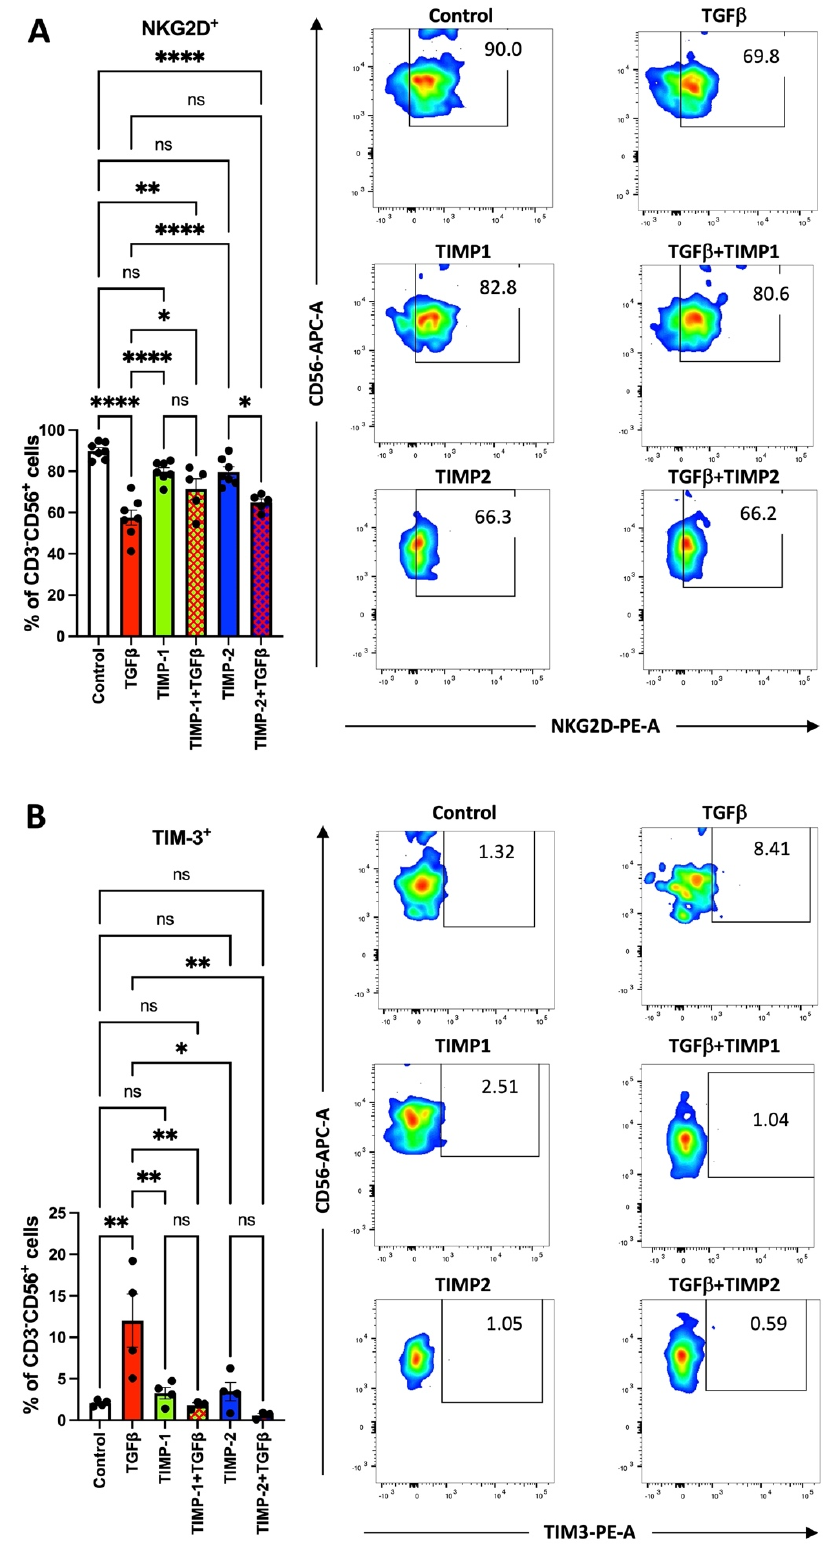
Figure 3. TIMP-1 and TIMP-2 treatments were effective in contrasting the TGF β -induced ability to decrease the surface expression of the NK cell activation marker NKG2D (panel A ) and the expression of the TIM-3 (panel B ) exhaustion marker. Results are shown as mean ± SEM, ANOVA, ns = not signficant; * p < 0.05; ** p < 0.01; **** p < 0.001. Representative plots are shown. Controls were cells in RPMI medium